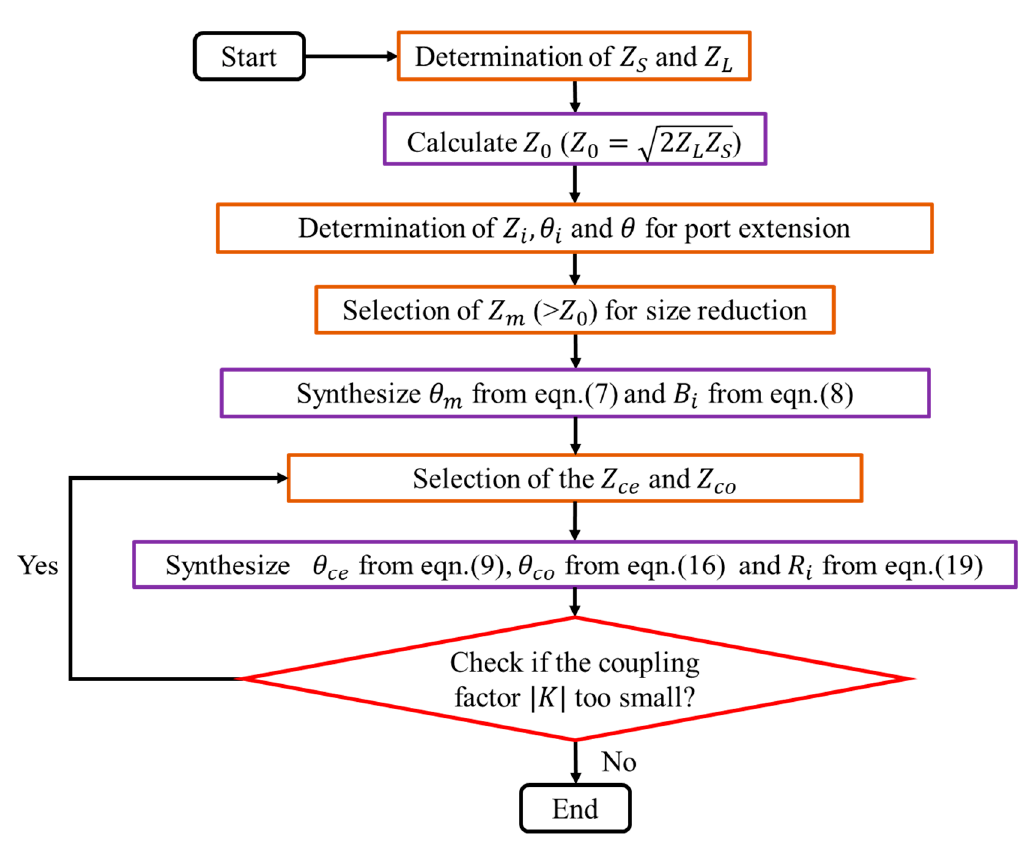
Figure 4. The complete design flow for the proposed power divider with port extension.